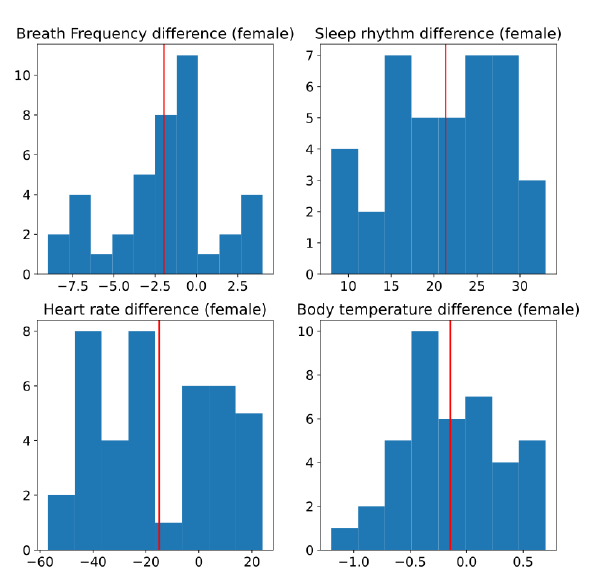
Figure 11. Histogram of difference between two conditions, without and with sensors. Red line is estimated